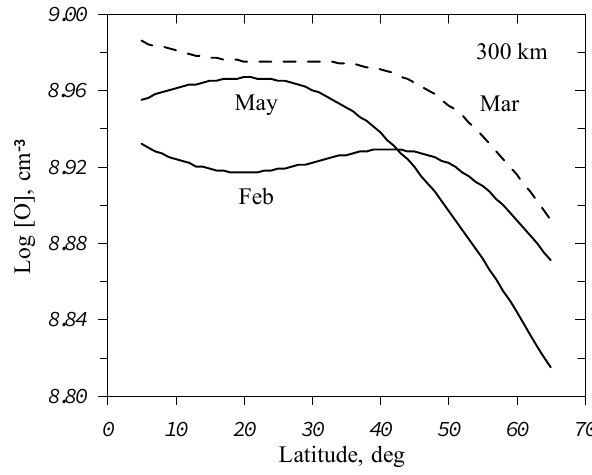
Fig. 3. The NRLMSISE-00 model latitudinal variations of Fig. 3. atomic oxygen concentration under F 10 . 7 =FS 10 . 7 =150, and A p =7 at 300km